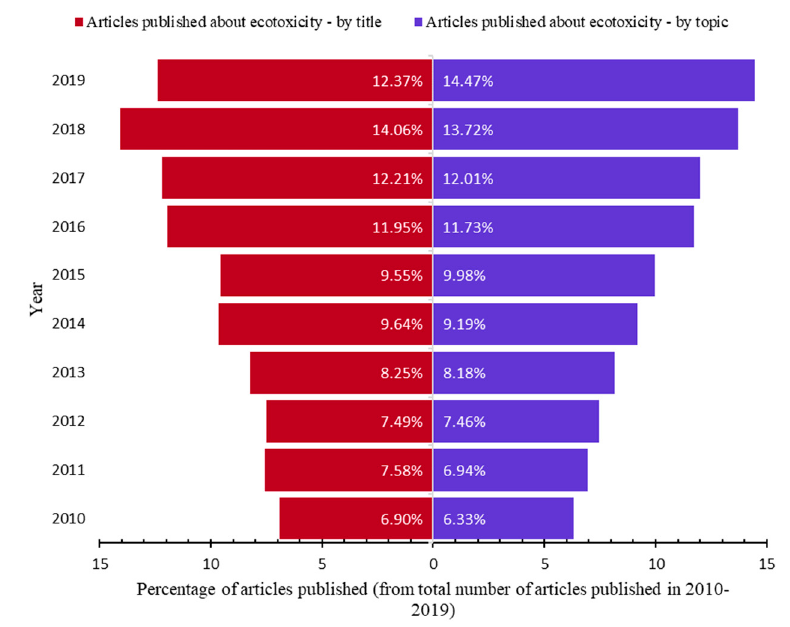
Figure 2. Bibliometric analysis of research on ecotoxicity in 2010–2019 from Web of Science Core Collection (Web of Science, Clarivate Analytics), the search strategy used to retrieve the data being: title search (TI) = (Ecotox*) (containing “ecotox” in the title of the articles) and TS = (Ecotox*) (containing “ecotox” in the topic of the articles).